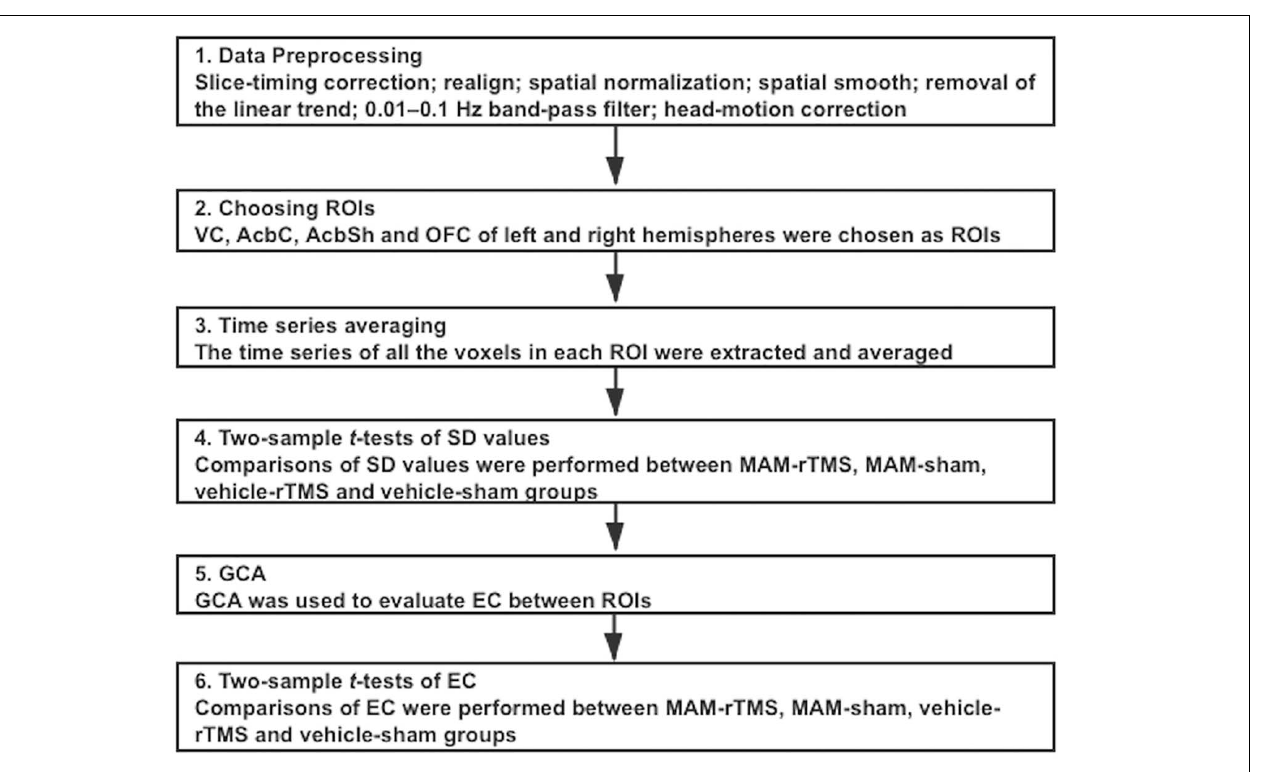
FIGURE 2 | Overview of the procedures of statistical analysis; ROI, regions of interest; VC, Visual Cortex; AcbC, Nucleus Accumbens Core; AcbSh, Nucleus Accumbens Shell; OFC, Orbitofrontal Cortex; SD, standard deviation; MAM, methylazoxymethanol acetate; rTMS, repetitive transcranial magnetic stimulation; GCA, Granger Causality Analysis; EC, Effective